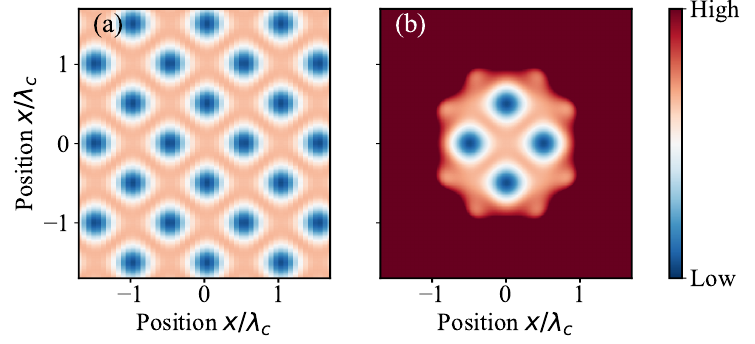
( z = 0 ) opt [ Eq. (12) ] . Each of the four wells 4well